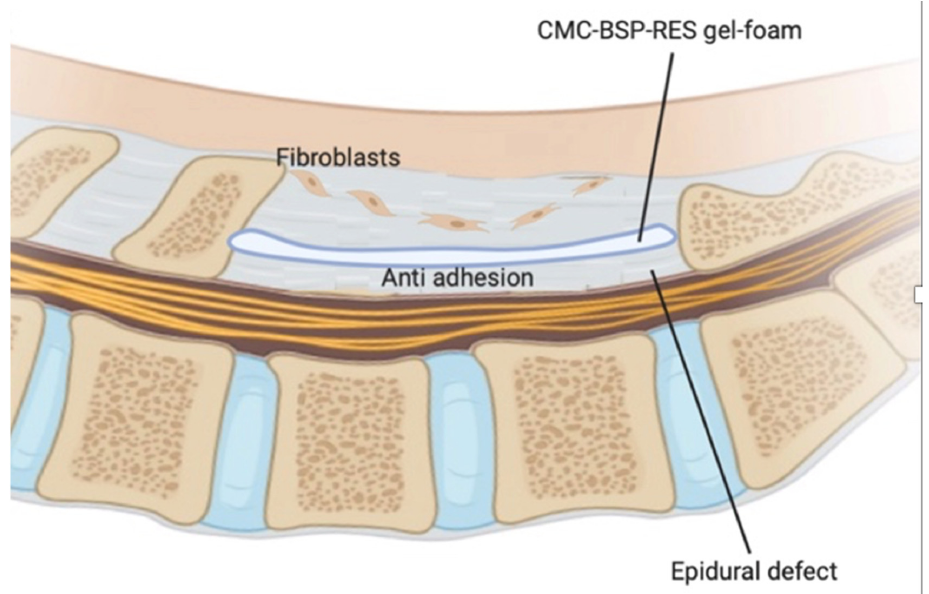
Figure 1. Schematic of the dual-layer CMC-BSP-RES sponge proposed in this study to effectively block invasive fibroblasts and reduce subsequent scar development in epidural defects and to promote post-wound regeneration.